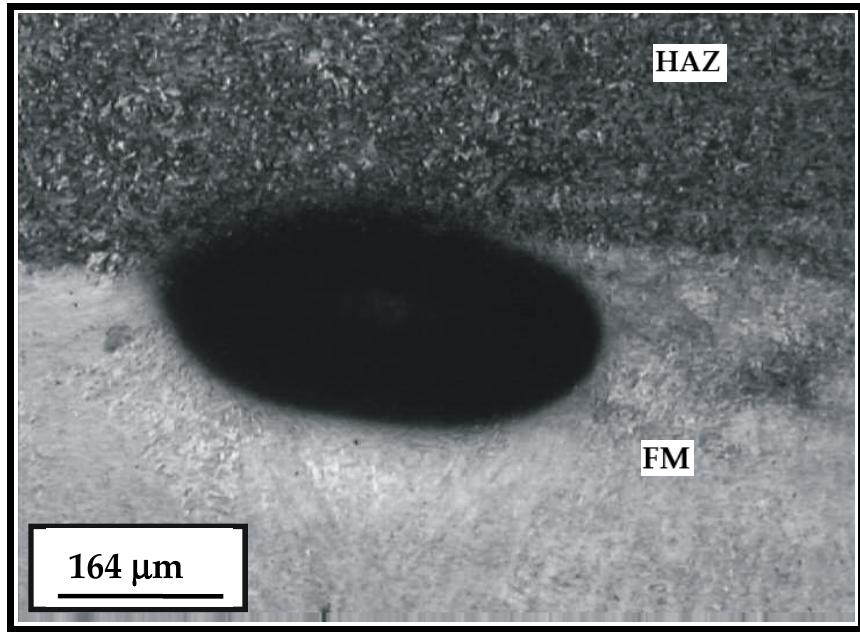
Figure 14. Microstructure of the hard-faced layer executed by the FM Phönix 120 K/E with appear- ance of the gas bubble in the HAZ.